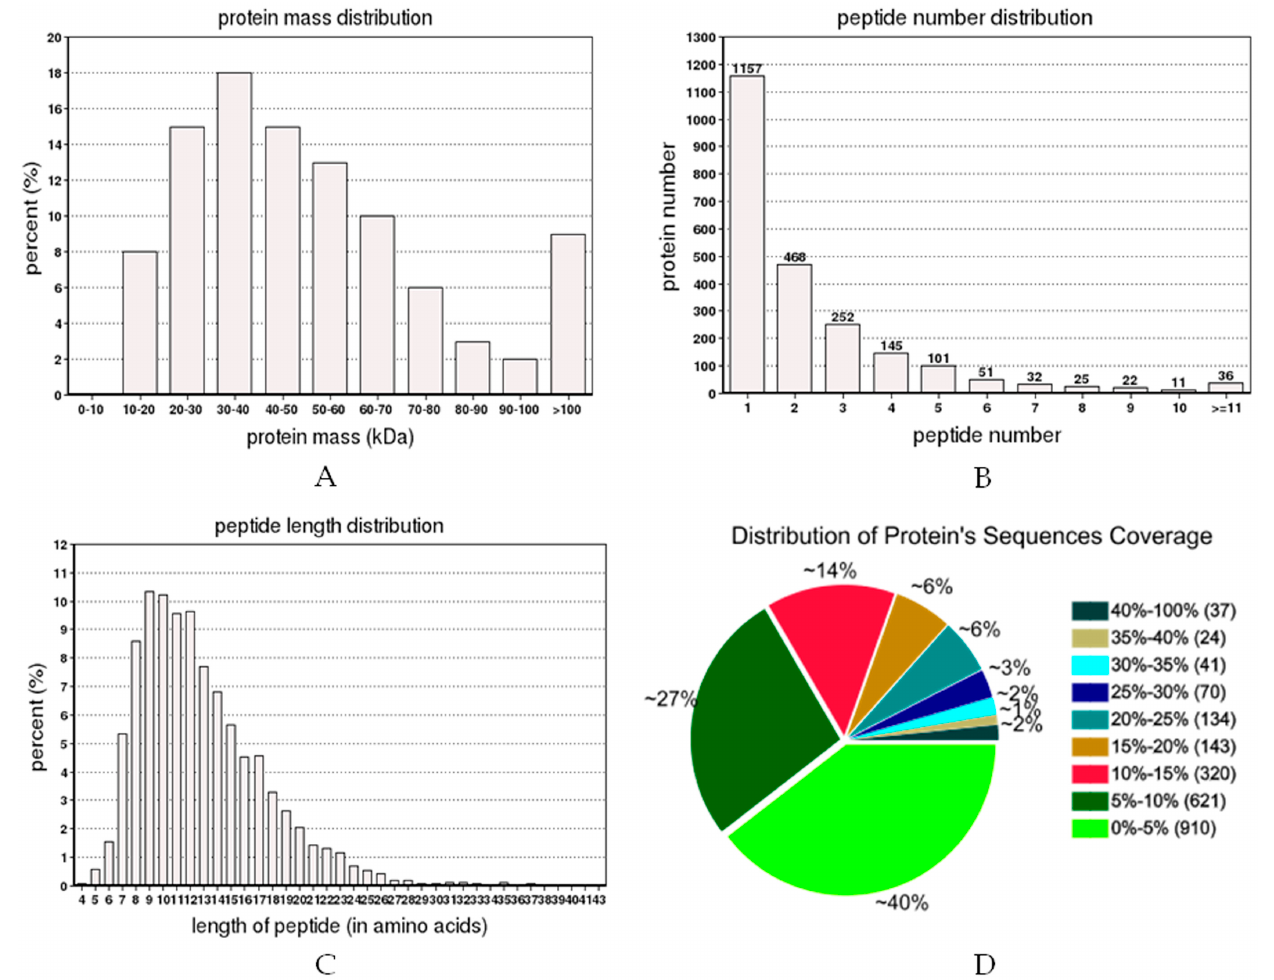
Figure 2. Identification and analysis of the proteome of O. sativa plants. ( A ) Identified proteins were grouped based on their protein mass; ( B ) Number of peptides that match to proteins as shown by Protein Pilot 5.0; ( C ) The percentage of different peptide lengths in total amino acids. ( D ) Distribution of a protein’s sequence